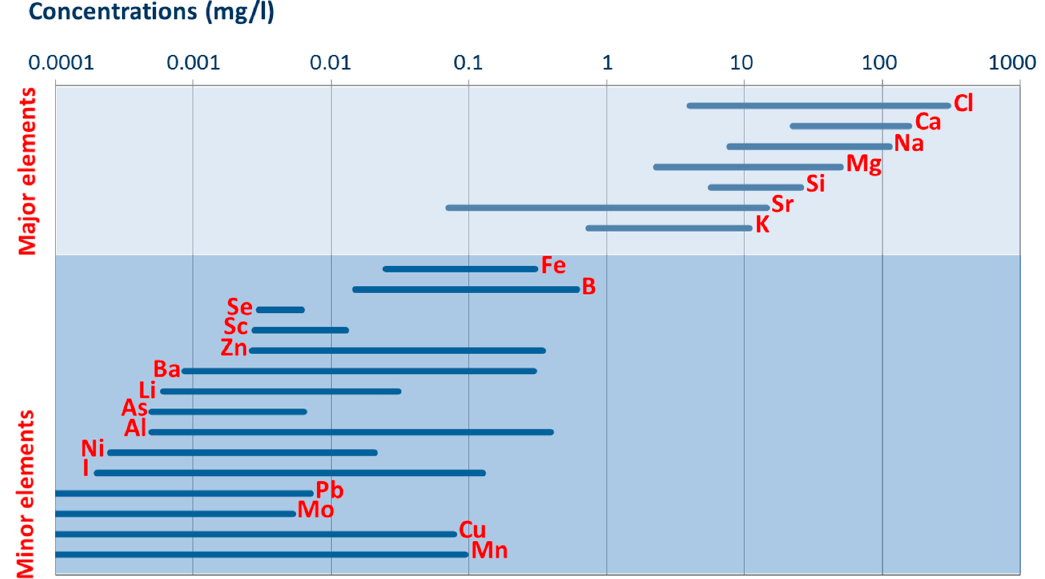
Figure 3. Concentration ranges for selected major and minor elements in drinking water from the 2013 sampling campaign of 144 major Danish waterworks revealing large concentration variability.